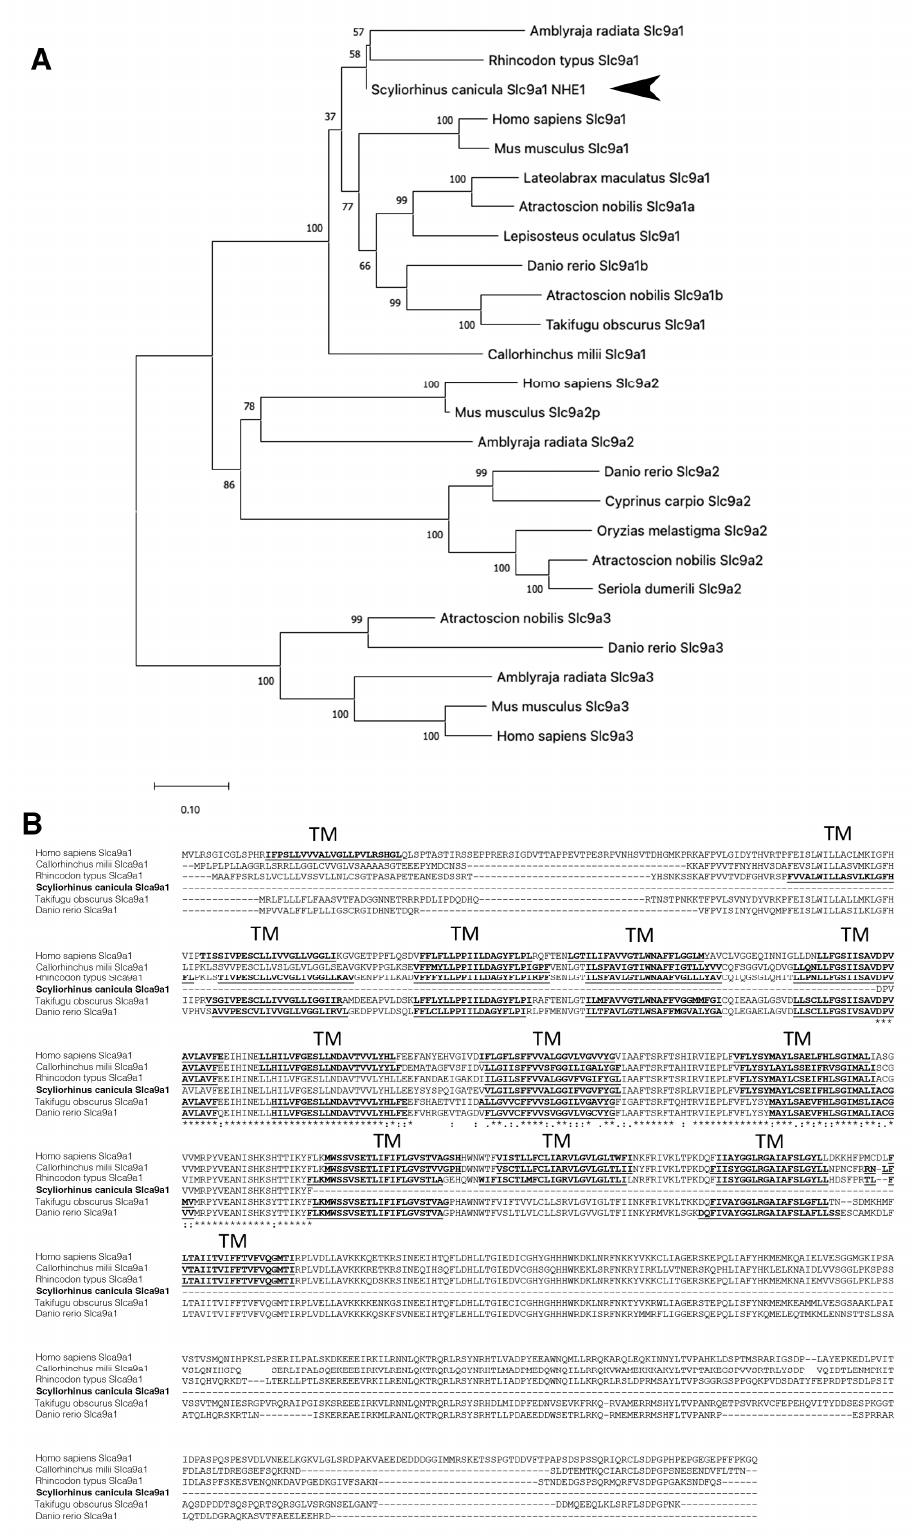
Figure 5. Phylogenetic and tree sequence analyses of slc9a1 (NHE1) from S. canicula . ( A ) Phylogenetic tree of the partial protein sequences of the identified small-spotted catshark NHE1 (indicated by black arrow) and other members of NHE family identified in other vertebrates. The phylogenetic tree was inferred using maximum likelihood method. The percentage of replicates trees in which the associated taxa clustered together in the bootstrap test (1000 replicates) are shown next to the branches. Scale bar refers to a phylogenetic distance of 0.10 amino acid substitutions per site. Acces- sion numbers are: human Homo sapiens , NM_003047.5 slc9a1, XM_047445572.1, slc9a2, NM_001284351.3 slc9a3; house mouse Mus musculus , NP_058677.1 slc9a1, NP_001028461.2 slc9a2,